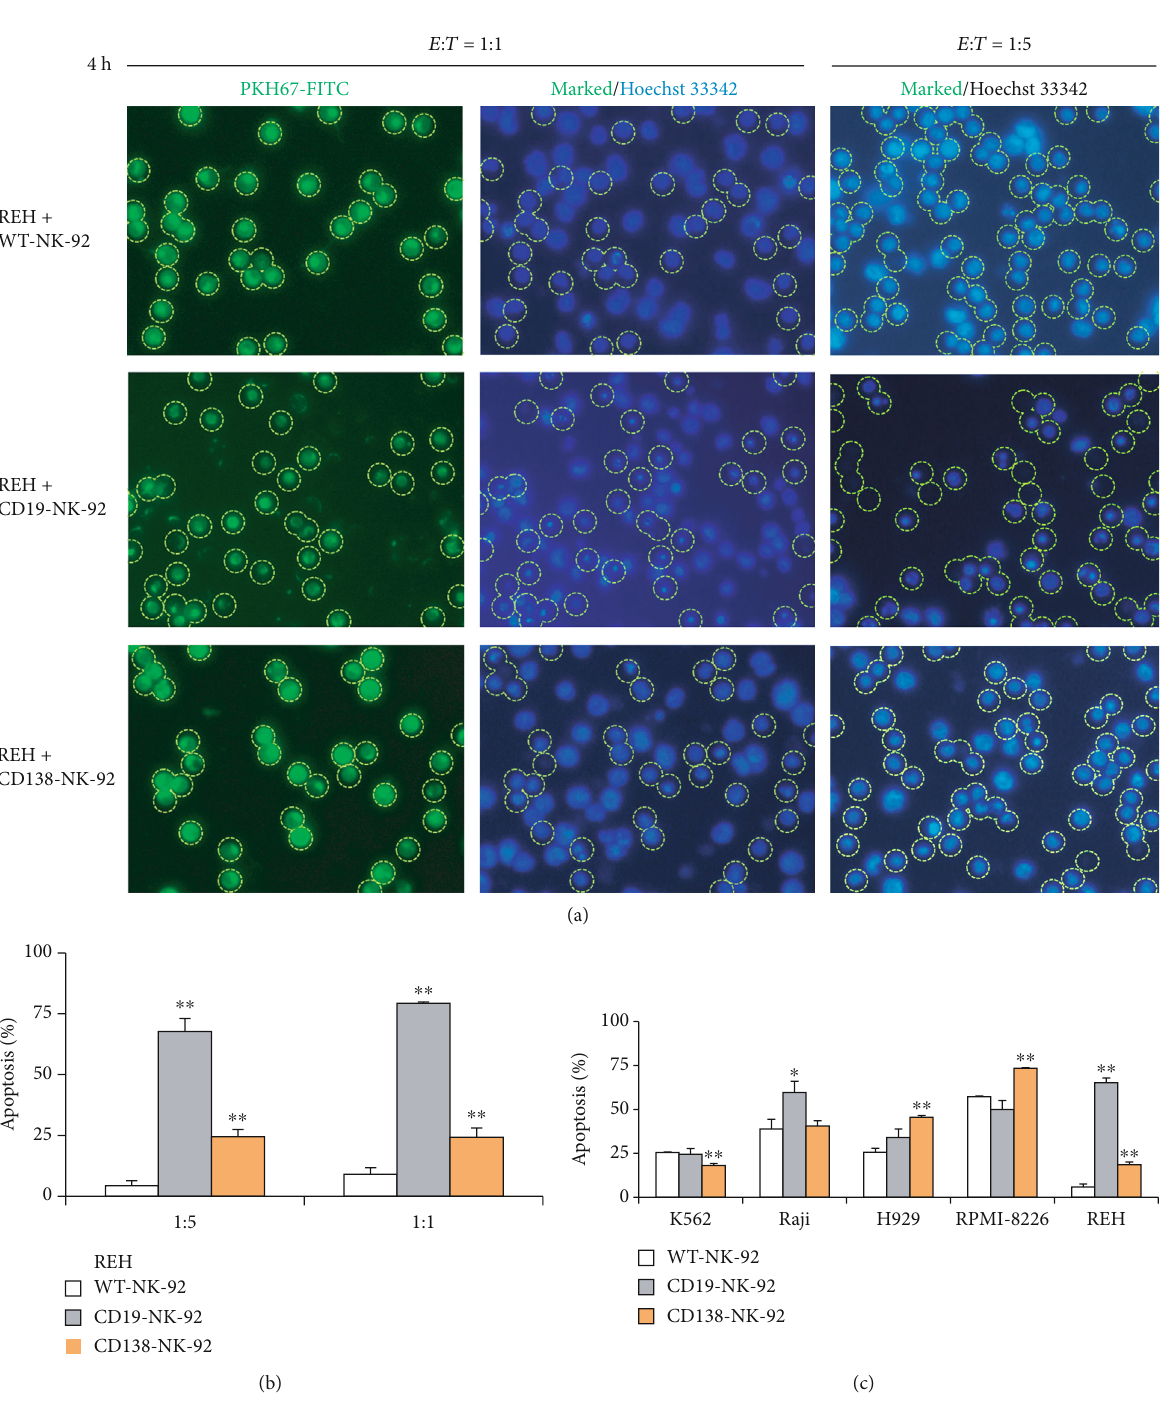
Figure 5: CD19-NK-92 and CD138-NK-92 cells selectively induced apoptosis of target cancer cells. Human ALL-derived REH cells were labeled with PKH67 dye; incubated with WT-NK-92, CD19-NK-92, or CD138-NK-92 cells at the E : T ratio of 1 :1 or 1 :5 for 4h; stained with Hoechst 33342; and visualized under a fl uorescence microscope. (a) Micrographs of PKH67-positive cells under green fl uorescence were used to mark the target cells and apoptosis of target cells was scored under blue fl orescence based on the fragmented/condensed nuclei. (b) Percentage of apoptosis over total REH cells was plotted. Data are mean ± s : d : ( n = 3 ). ∗ p < 0 : 05 and ∗∗ p < 0 : 01 versus WT-NK-92 cells at the same condition; two-sided Student ’ s t -test. (c) Apoptosis of PKH67-labeled CML-derived K562, BL-derived Raji, MM-derived H929 and RPMI-8226, and ALL-derived REH cells upon incubation with WT-NK-92, CD19-NK-92, or CD138-NK-92 cells at the E : T ratio of 1:5 for 4h was similarly determined by Hoechst 33342 assay. Percentage of apoptosis over total target cells was plotted. Data are means ± s : d : ( n = 3 ). ∗ p < 0 : 05 and ∗∗ p < 0 : 01 versus WT-NK-92 cells; two-sided Student ’ s t